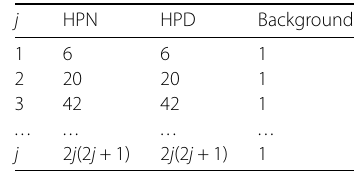
Table 2 Main mathematical features of rational solutions u n and v n of order j j HPN